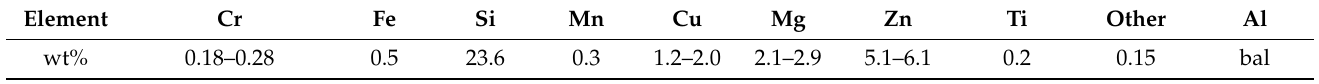
Table 2. Composition of 7075 aluminum